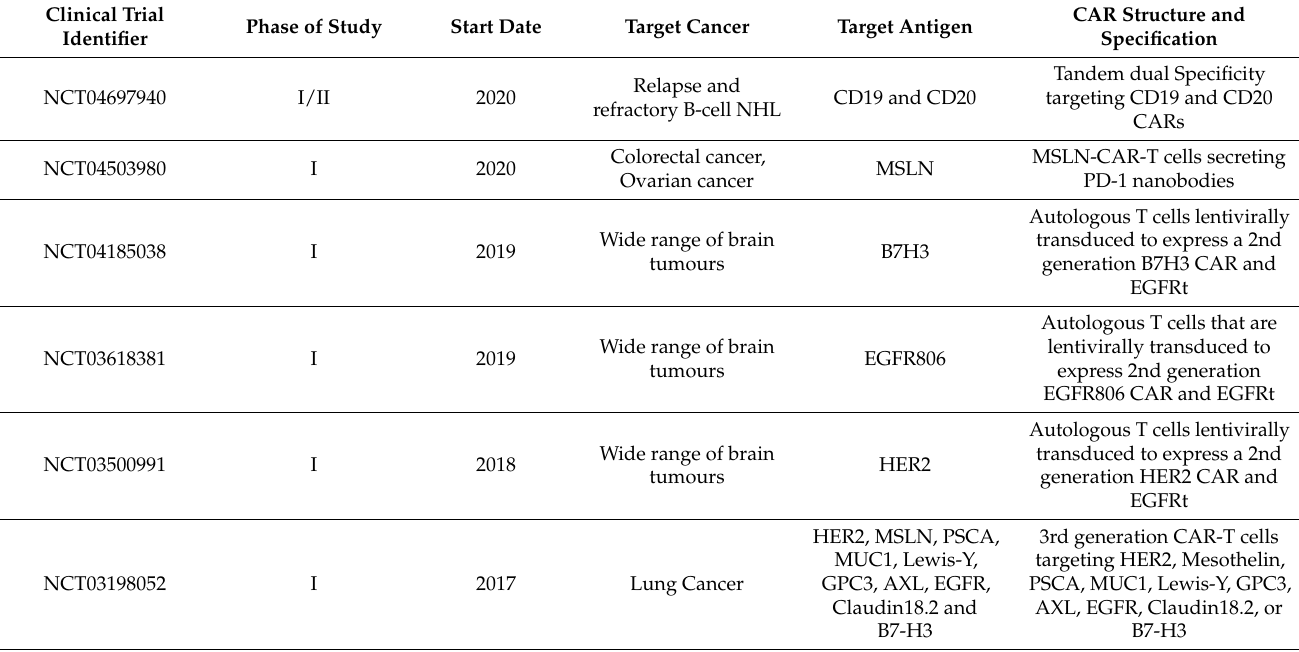
Table 1. List of recent clinical trials for CAR T cell